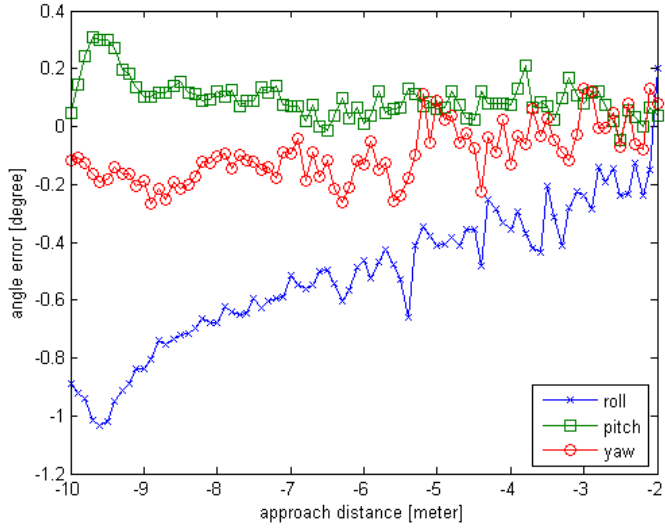
Figure 10. The rotation error curve of Experiment 3 for relative motion.